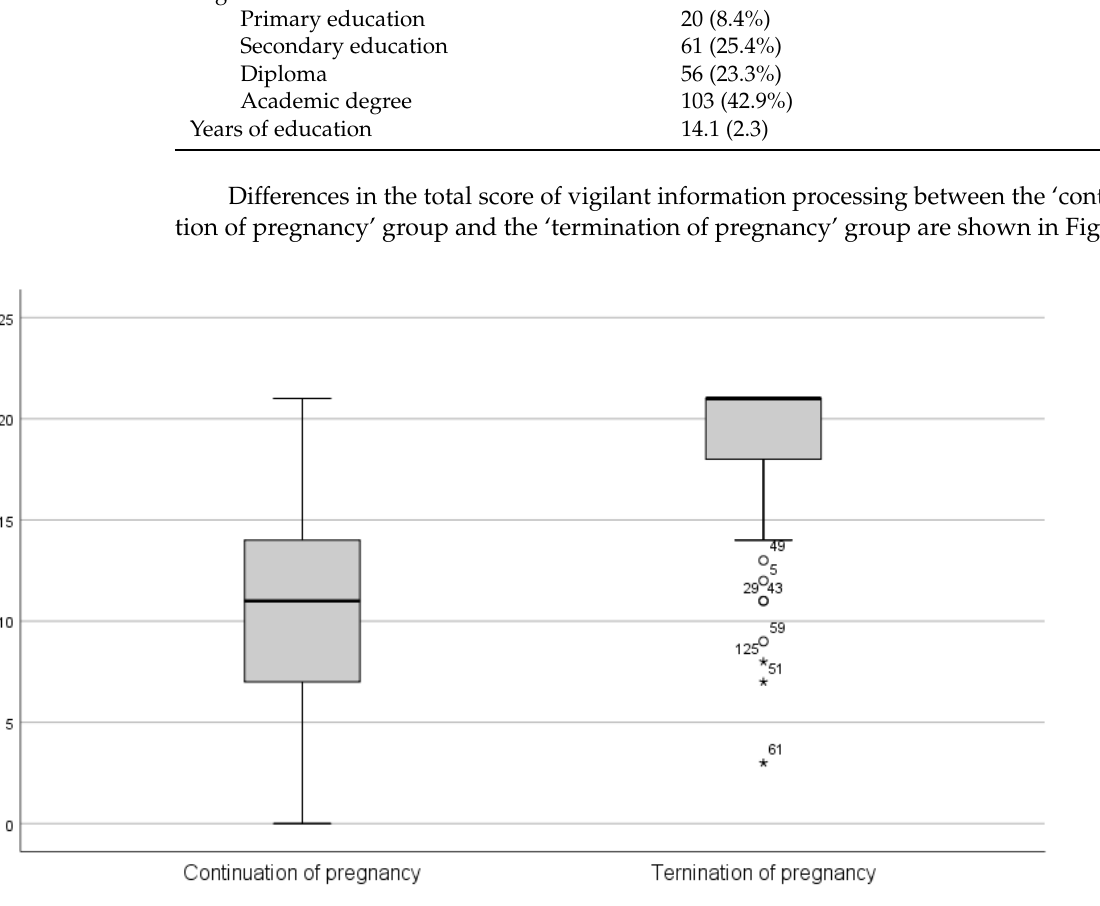
Figure 2. Utilization of information sources—comparison between ‘continuation of pregnancy’ and ‘termination of pregnancy’ groups; ** p < 0.001.